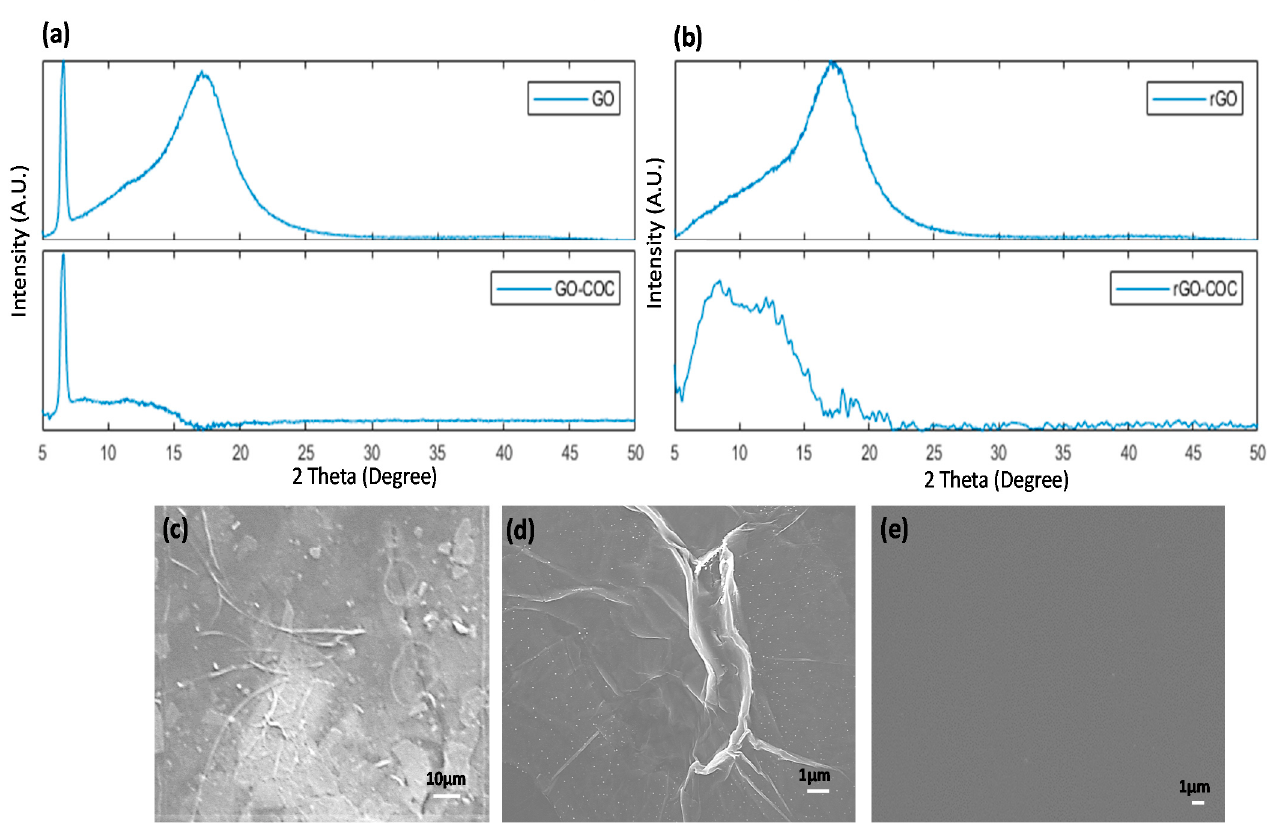
Figure 3. XRD pattern for ( a ) COC coated with pristine GO and diffractogram of the COC substrate subtracted from GO XRD, ( b ) GO reduced thermally for 12 h and diffractogram of the COC substrate subtracted from rGO XRD. ( c – e ) present microphotographs of the GO, rGO, and COC, respectively, captured using a field emission scanning electron microscope.